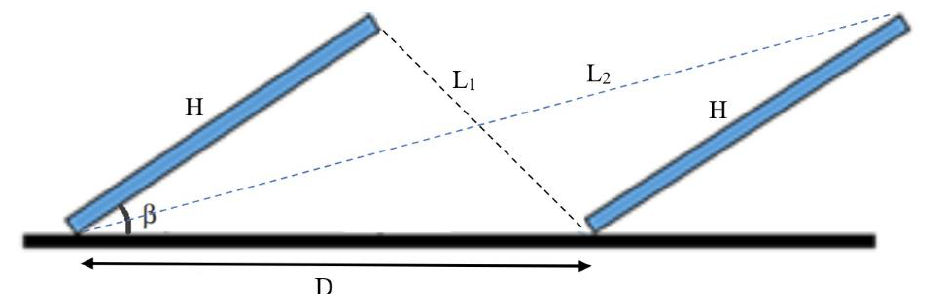
Figure 3. Layout view factor of roof to sky and front side of PV panel.